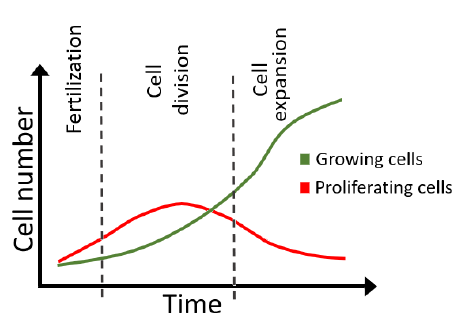
Figure A1. Early fruit development phases. Initially, the number of cells that are proliferating is greater and, with the passage of time, the majority of cells are expanding. Adaptation from tomato fruit development studies [19,35]. Tomato and zucchini could share early fruit development stages since both fruits are anatomically berries. In cucumber, the cell division phase is described until day 4 post pollination, and the cell expansion peak is 8 days post pollination [22].